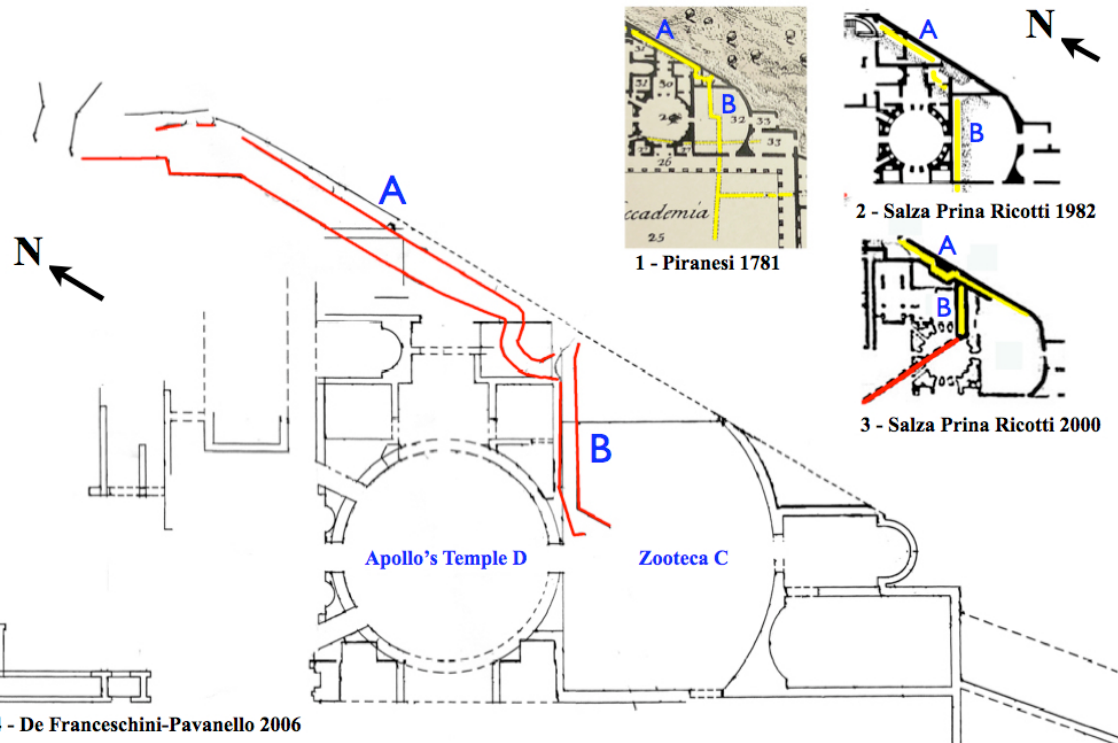
Fig. 3. Comparing ancient and modern plans of the subterranean network of service tunnels. 1: Piranesi 1781; 2: Salza Prina Ricotti 1982; 3: Salza Prina Ricotti 2000; 4: De Franceschini – Pavanello 2006. (A) Cryptoporticus; (B) corridors linked to the